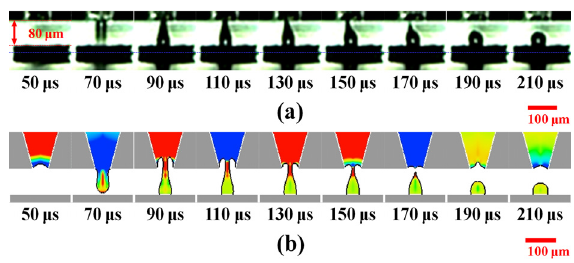
Figure 6. Evolution of dispensing process for gap of 80 μ m. ( a ) Experimental observations and ( b ) Simulation results.